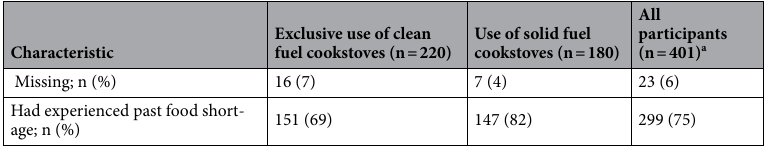
Table 1. Characteristics of study participants by current cooking fuel use. SD standard deviation, RMB Renminbi, IQR interquartile-range. a Includes 1 participant with measured personal exposure to air pollution but missing fuel use data. b Only never smokers reported whether they lived with a smoker. For statistical